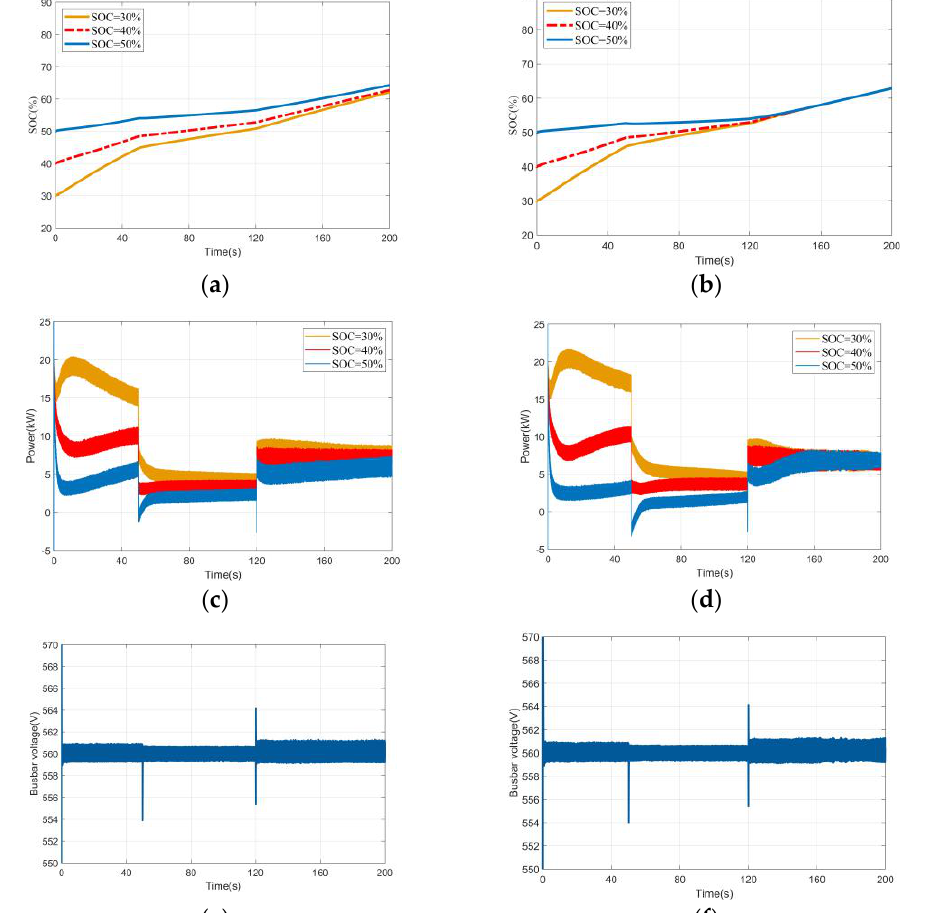
Figure 16. Simulation waveform of charging under load and FC power variation. ( a ) SOC sag control, lithium battery SOC waveform; ( b ) improved SOC sag control, lithium battery SOC waveform; ( c ) SOC sag control, lithium battery power waveform; ( d ) improved SOC sag control, lithium battery power waveform; ( e ) SOC sag control, bus voltage waveform; ( f ) improved SOC sag control, bus voltage waveform.